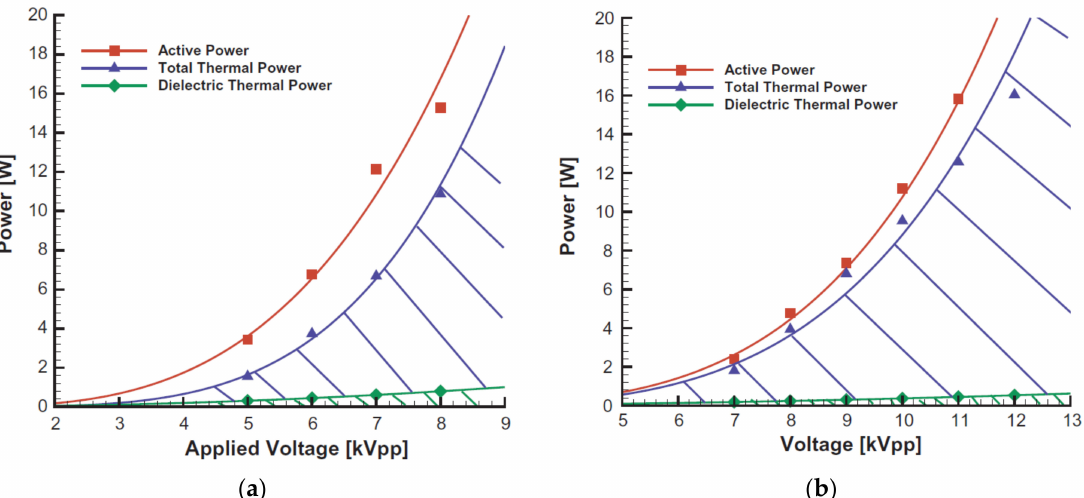
Figure 10. Comparison between active power, total thermal power generated, and power dissipated as dielectric heating in plasma actuators operating at different voltage levels and 24 kHz: ( a ) actuator made of Kapton with 0.3 mm thickness and ( b ) actuator made of Kapton with 1.02 mm thickness (reproduced from Rodrigues et al.